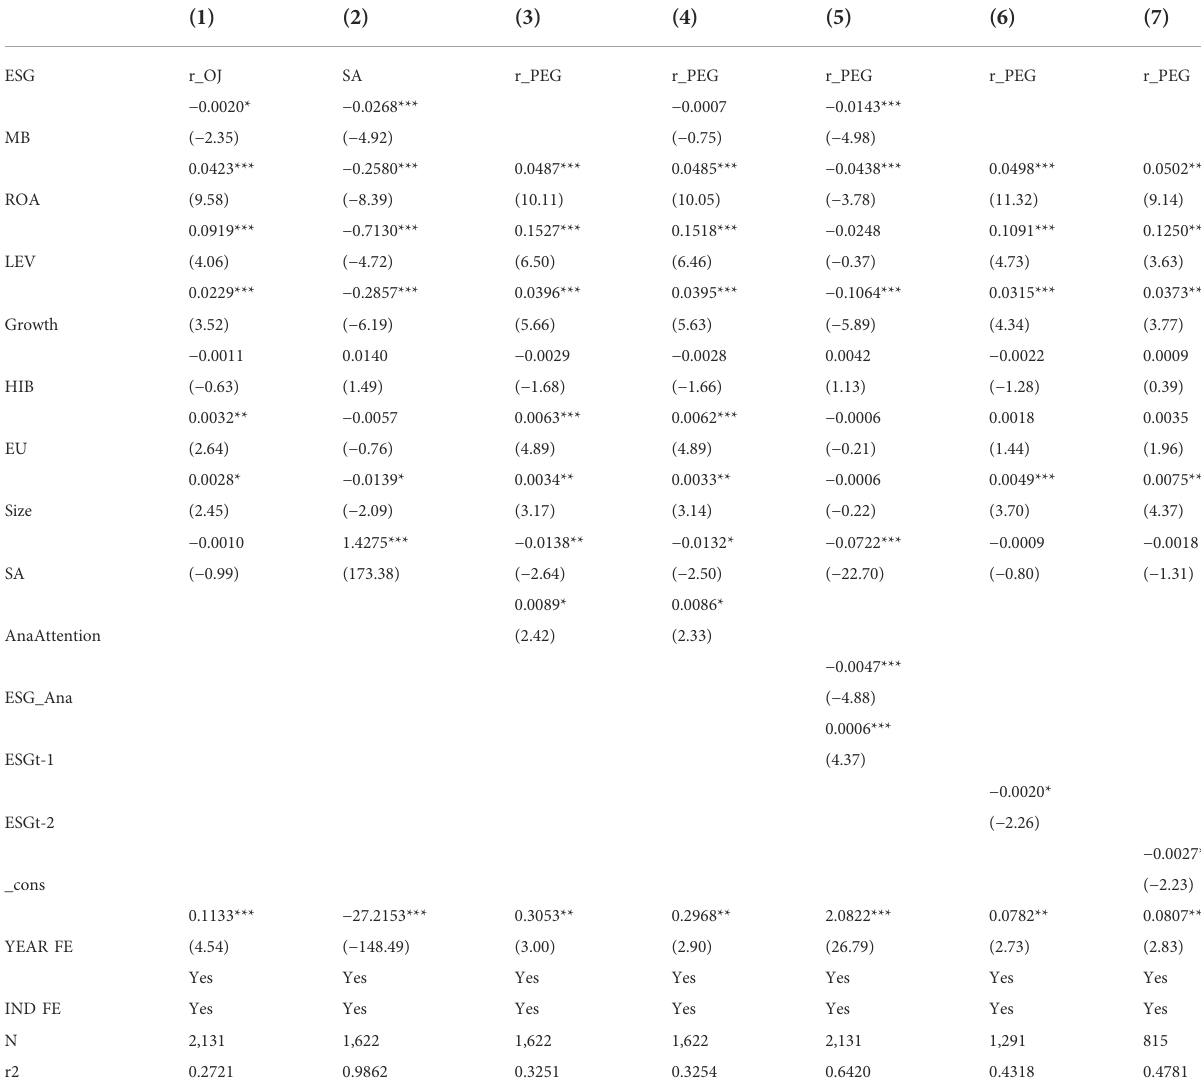
TABLE 5 The robustness checks of replacing variable and Lagging explanatory